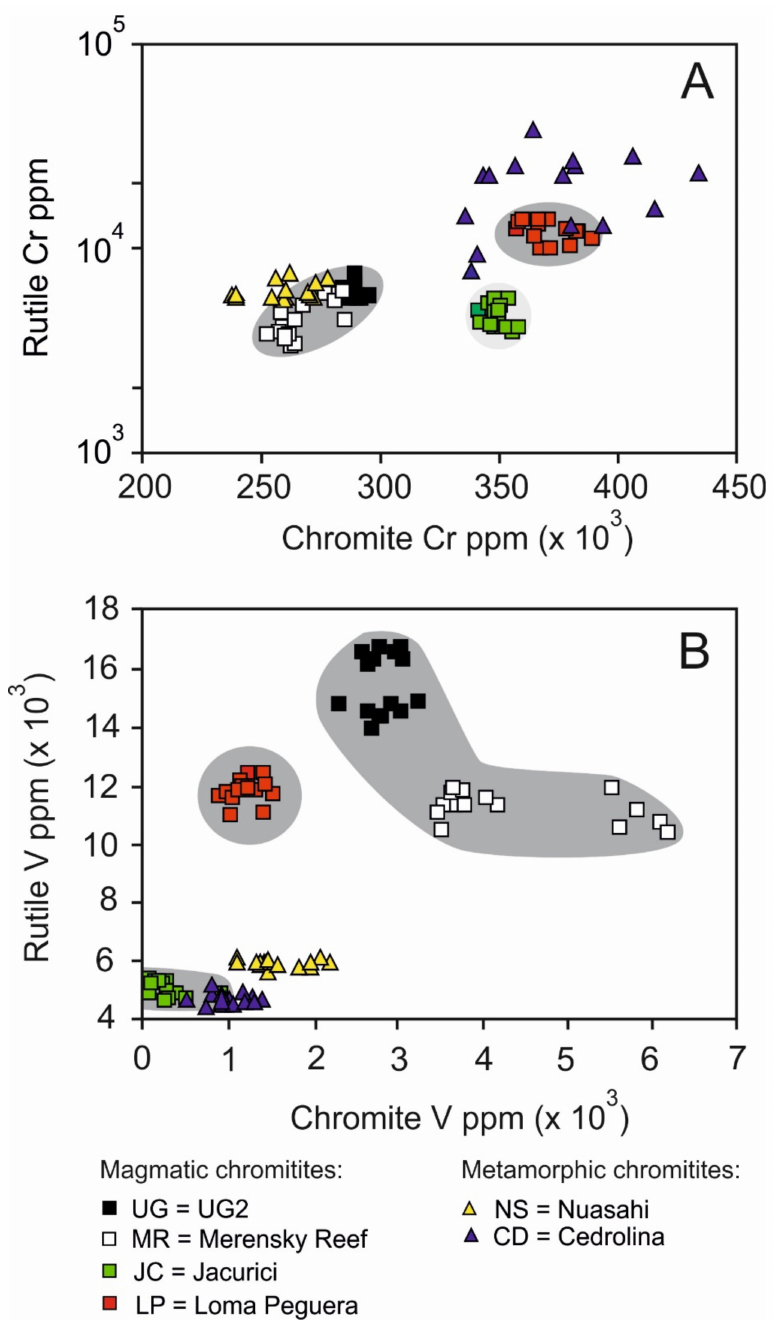
Figure 12. Correlation between the Cr-V contents in rutile, and Cr-V in the host chromite ( A , B ). The gray fields emphasize Cr-V variations in magmatic